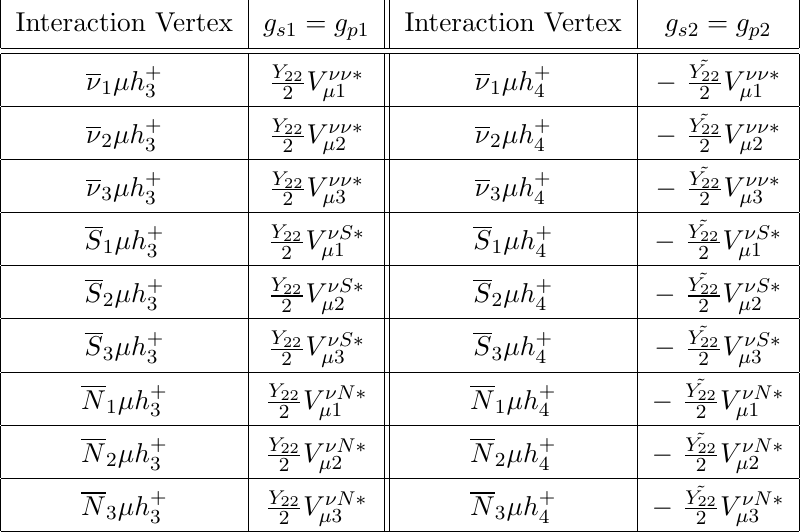
; h (cid:0) given in 3 4